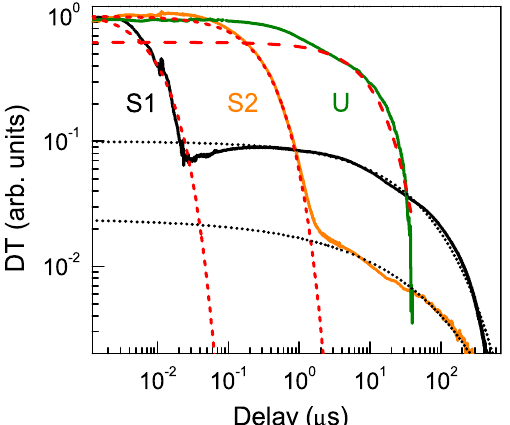
Figure 3. Transient absorption transients for crystals U, S1, and S2, spanning 1 ns to 1 ms timescale (Temperature T = 80 K, excitation fluence = 3 mJ/cm 2 ). Dashed lines for all samples show exponential fits that describe Shockley–Read–Hall (SRH) recombination. Dotted lines for S1 and S2 indicate stretched exponent fits for decay